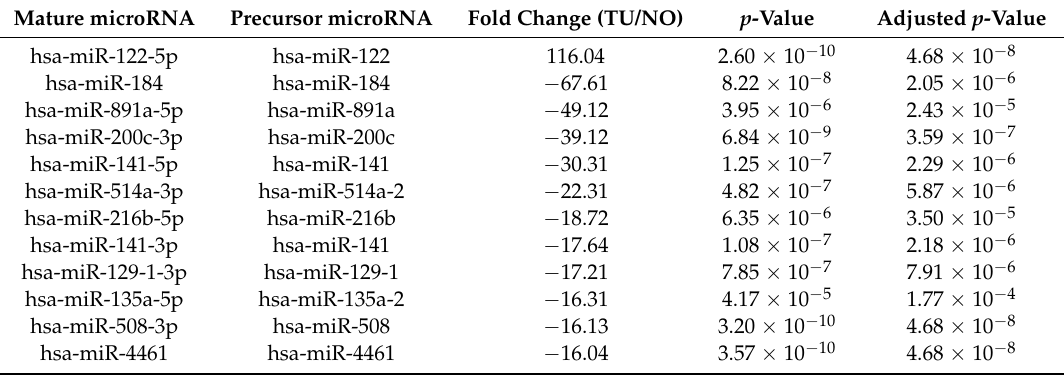
Table 2. The 20 miRNAs with the highest absolute fold change. TU: tumour, NO: normal. Mature microRNA